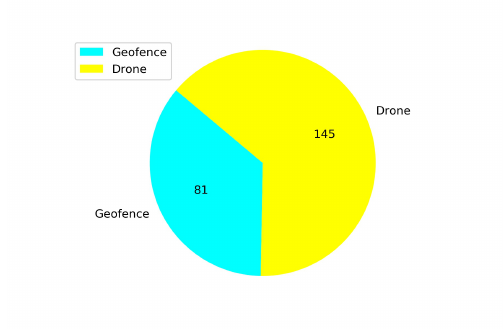
Figure 26. Crash report chart for Case